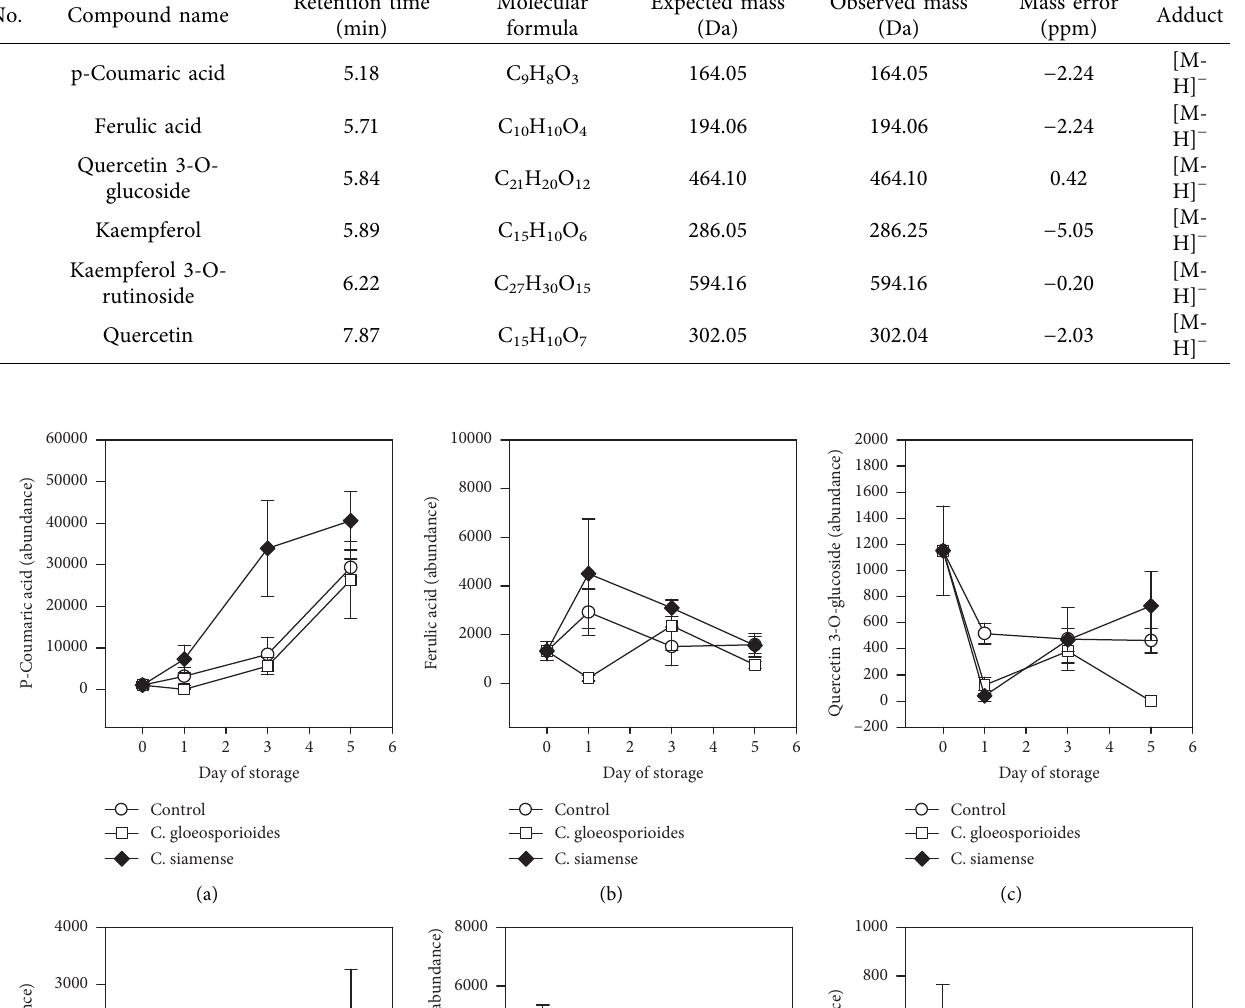
Table 2: Identification of soluble phenols in soursop by UPLC-ESI-QTOF MS E .